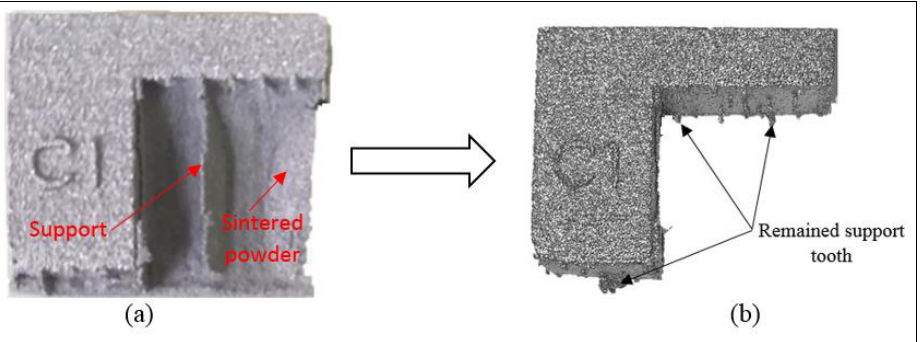
Figure 11. Specimen C1 (current = 1.25 mA) ( a ) before powder-blasting process, and ( b ) after powder-blasting process.